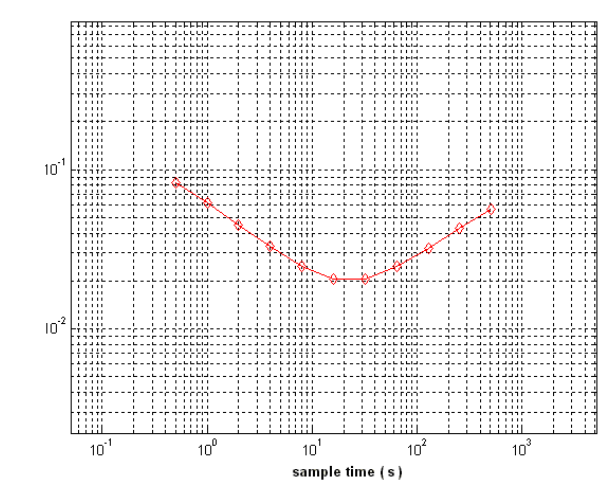
Figure 17. Plots of Allan variance for gyroscopes. (a) X/Y-axis gyroscope; (b) Z-axis